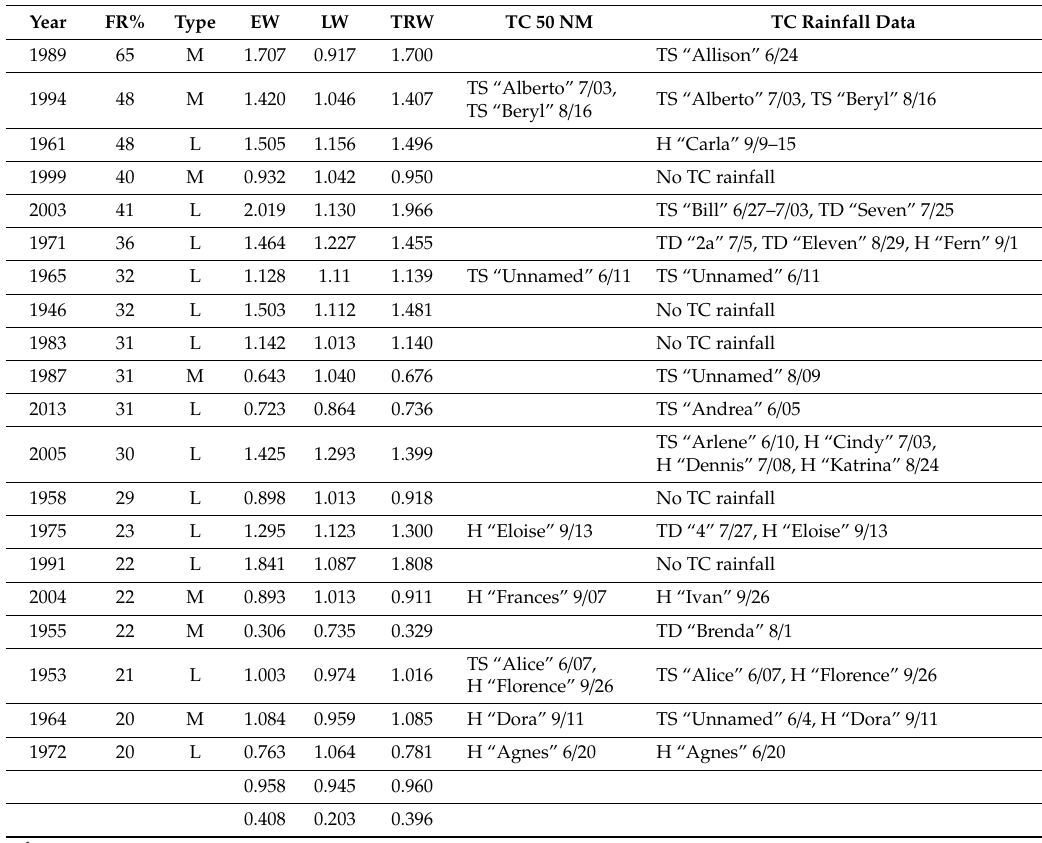
1 Proportion of trees indicating a false ring (FR%), location of FR within the annual ring (type), earlywood width (EW), latewood width (LW), total ring width (TRW), tropical cyclones passing within 50 nautical miles of the center of the watershed (tropical cyclone (TC) 50 nautical miles (NM)) and TCs causing heavy rainfall in the basin (TC rainfall data). Date format is month / day. Mean and standard deviation (respectively) of tree ring width parameters for the 67 years analyzed are given in the last two